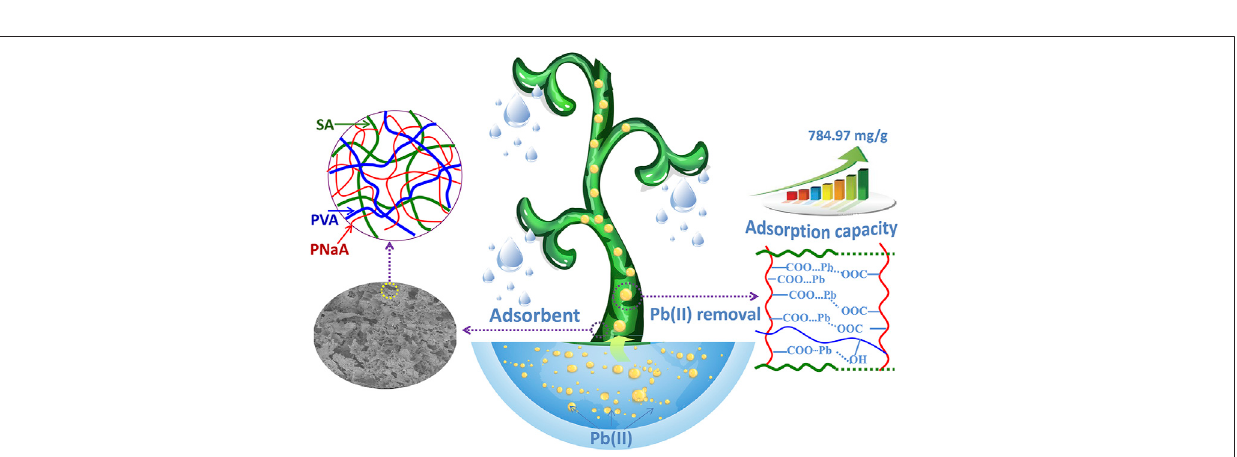
SCHEME 1 | Scheme illustrated the gel network structure of the adsorbent and its adsorption actions for Pb(II).